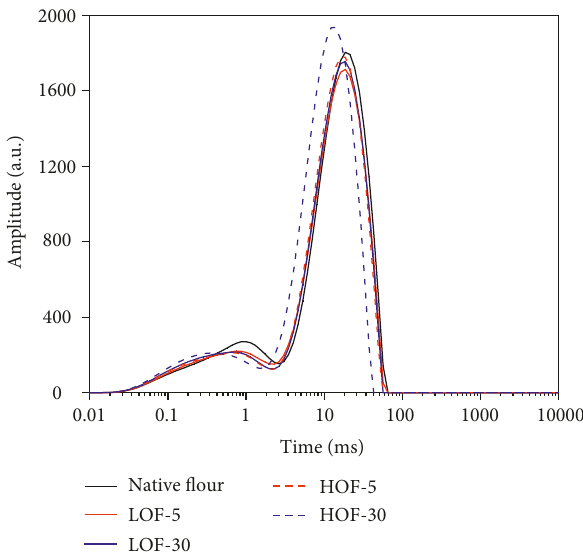
Figure 6: RVA curves of native and ozone-treated wheat flours. LOF-5: wheat flour treated at low-intensity condition for 5min; LOF-30: wheat flour treated at low-intensity condition for 30min; HOF-5: wheat flour treated at high-intensity condition for 5min; HOF-30: wheat flour treated at high-intensity condition for